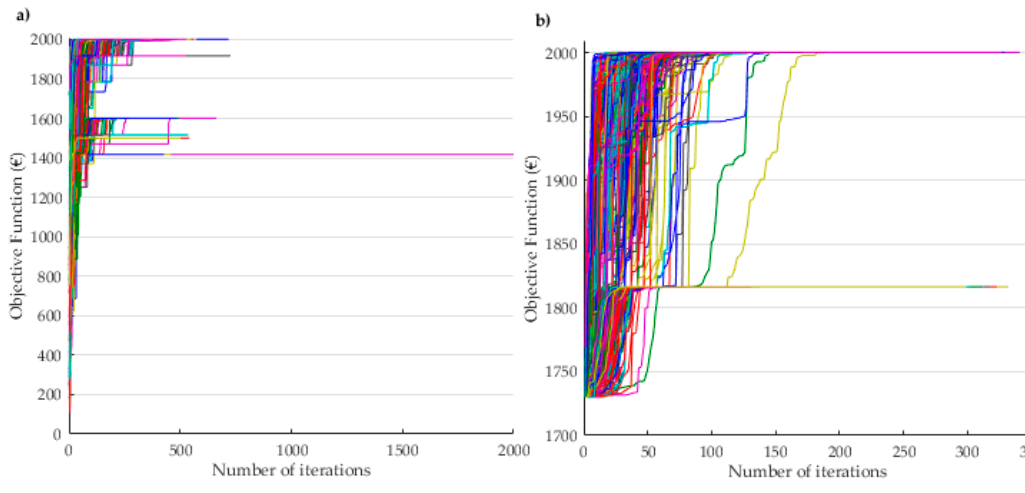
Figure 7. ( a ) MPSO-TVAC (random solution); ( b ) MPSO-TVAC (heuristic solution).